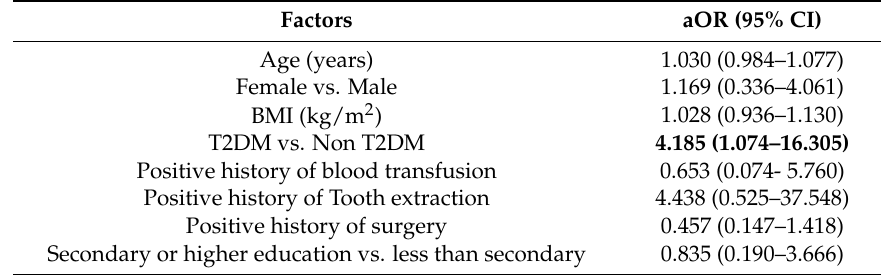
Table 2. Multivariable analysis for factors associated with viral hepatitis C seropositivity among patients attending primary health care centers ( n =